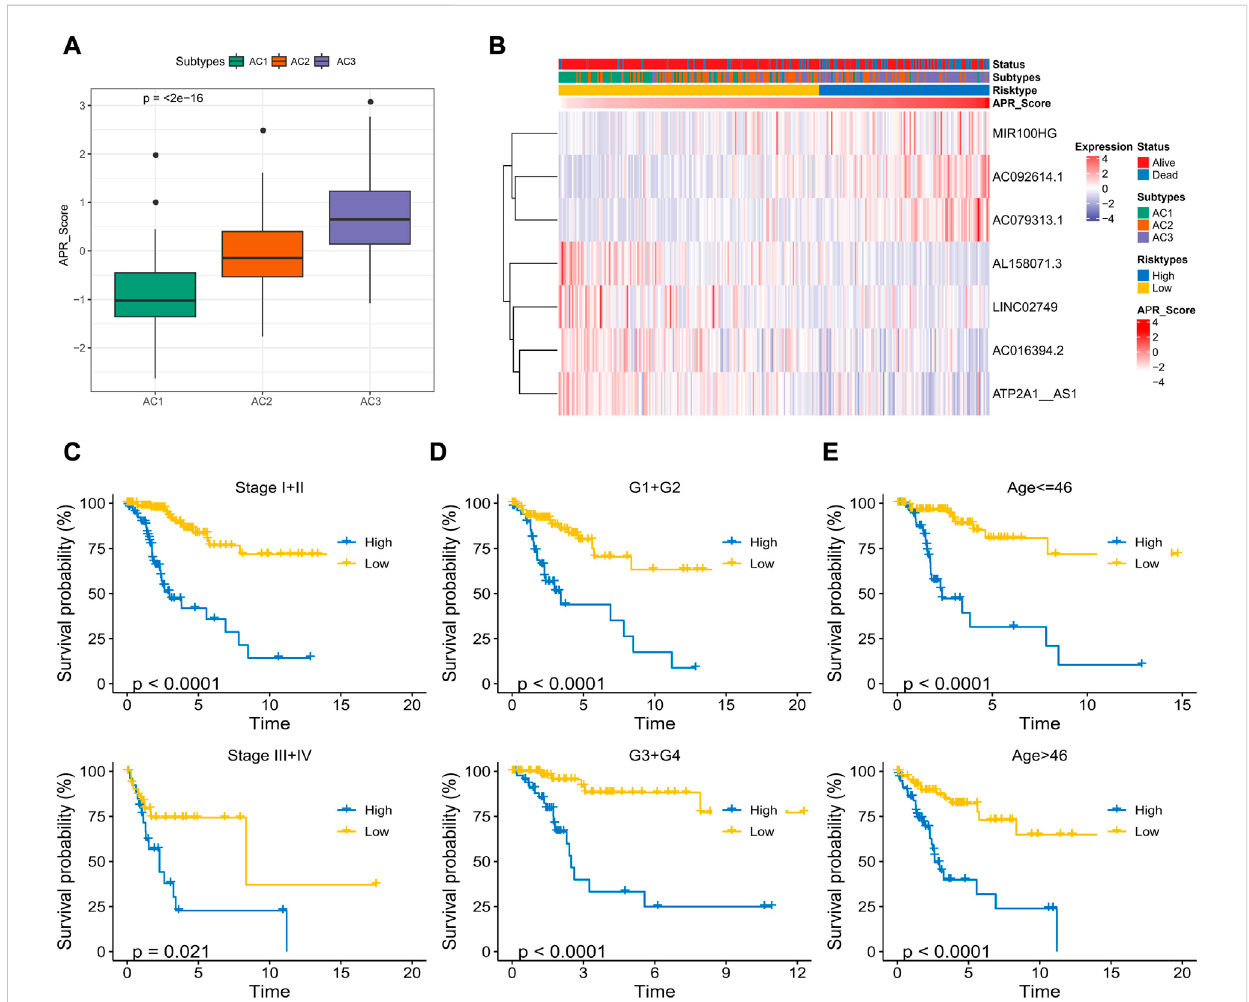
FIGURE 7 Correlation between APR_Score and clinical characteristics of CC (A) APR_Score in AC1-3 subtypes (B) Heatmap showing the expression of 7 OS- related ARLs in ARLs-related molecular subtypes and APR_Score groupings (C – E) K-M curves for patients with high APR_Score and low APR_Score in Stage, Grade, and Age